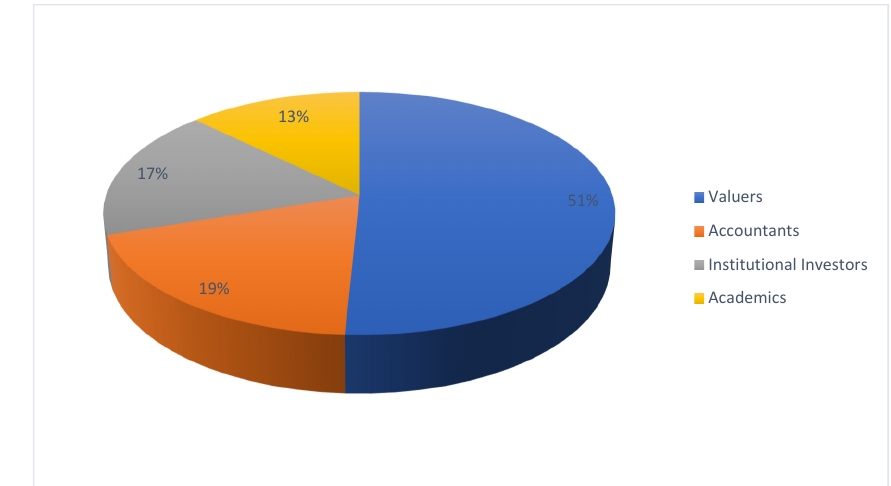
Figure 1. Demographic and Profile of the Respondents.